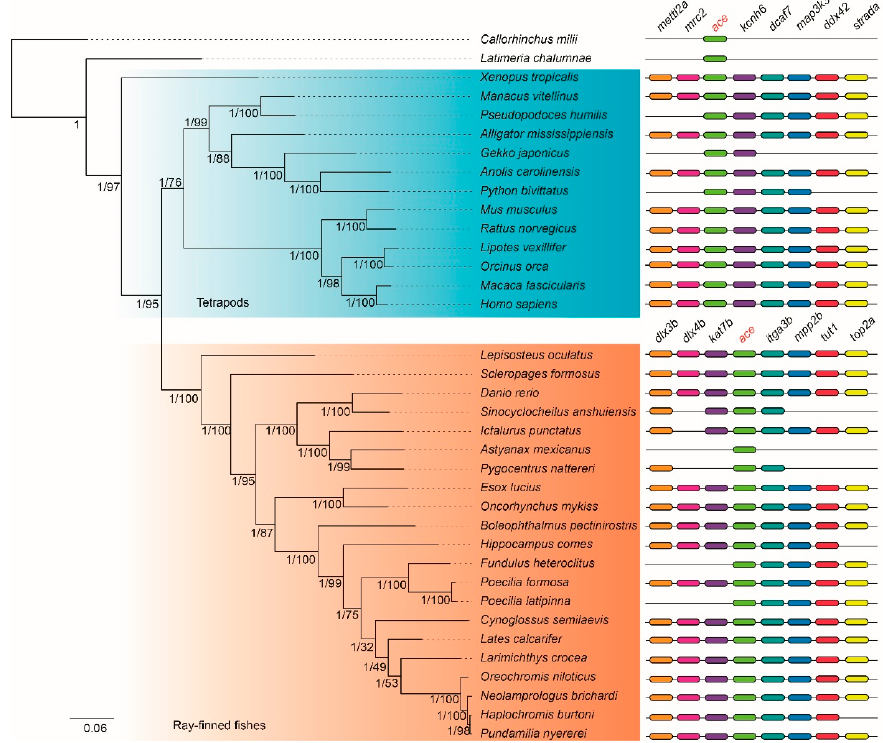
Figure 2. A phylogenetic tree based on 36 ace synteny sequences. The left and the right numbers in each node indicate the Bayesian posterior probability (BPP = 1) and the node supports (generated by the ML method), respectively. The scale bar represents nucleotide substitutions per site.